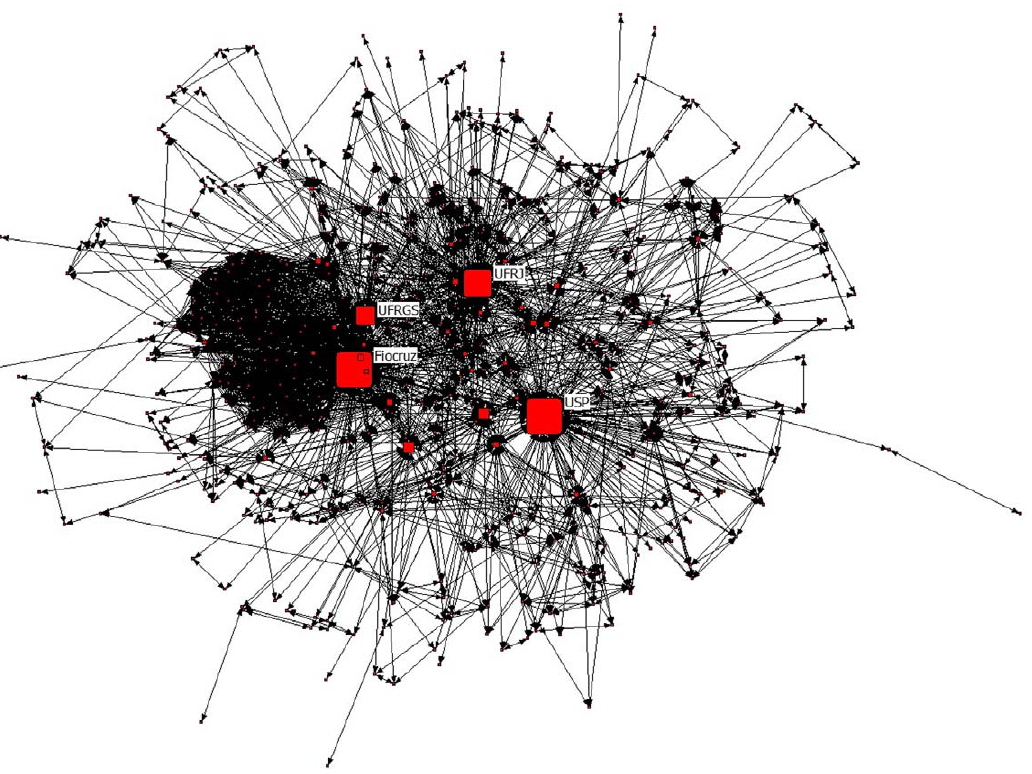
Figure 3. Major component of the network of Brazilian institutions working on tuberculosis, 1995–2010. Node size proportional to the calculated betweenness centrality measure of institutions. Four institutions have a central role in the network according to this indicator: University of Sa˜o Paulo (USP), Oswaldo Cruz Foundation (Fiocruz), Federal University of Rio de Janeiro (UFRJ) and Federal University of Rio Grande do Sul (UFRGS).